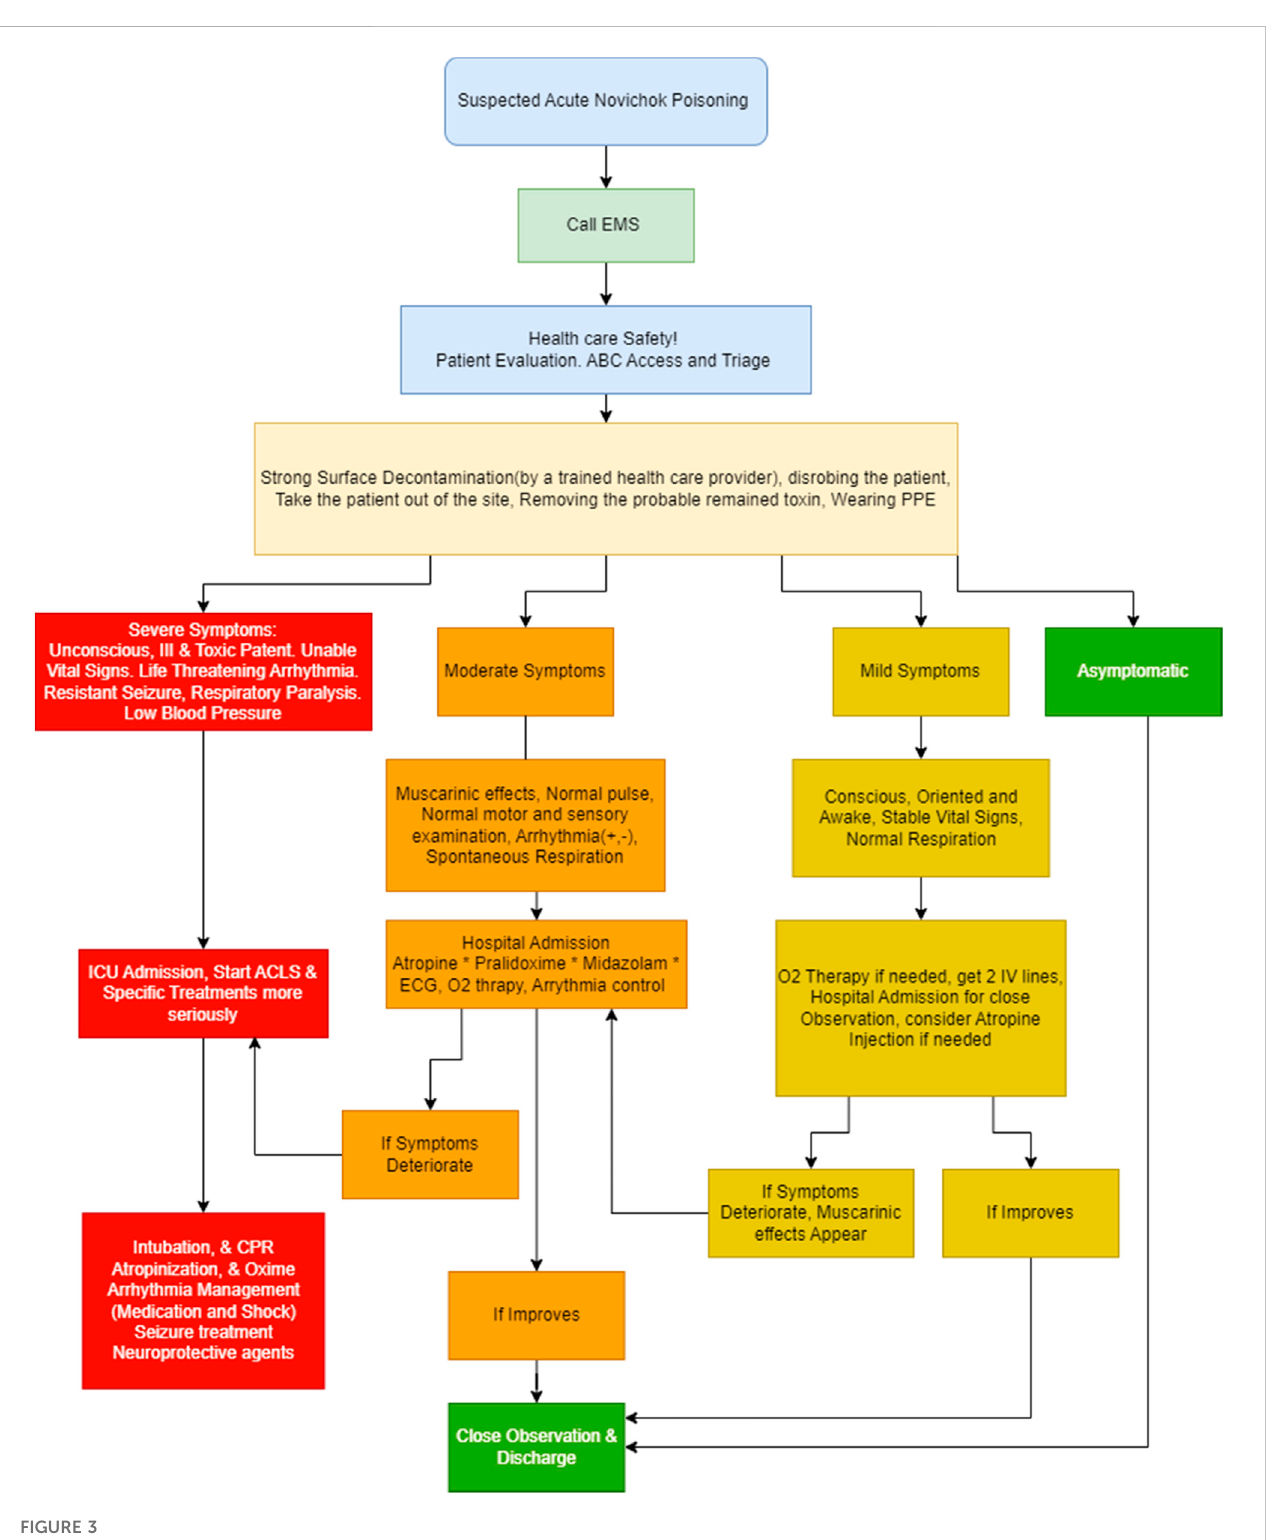
FIGURE 3 The clinical management approach in exposing Novichok (nerve agent)